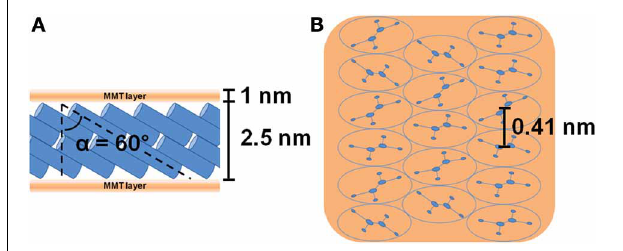
FIGURE 2 | Schematic projections parallel (A) and perpendicular (B) to the clay layers of the starting MMT/2HT (OMMT) intercalate structure. The hydrocarbon tails of the ammonium cations are represented as cylinders in the lateral view (A) and as ellipses in the top view (B) . The distance between the axes of adjacent cylinders (0.41nm) is shown in (B) while the definition of the alkyl chains tilt angle is shown in (A) .